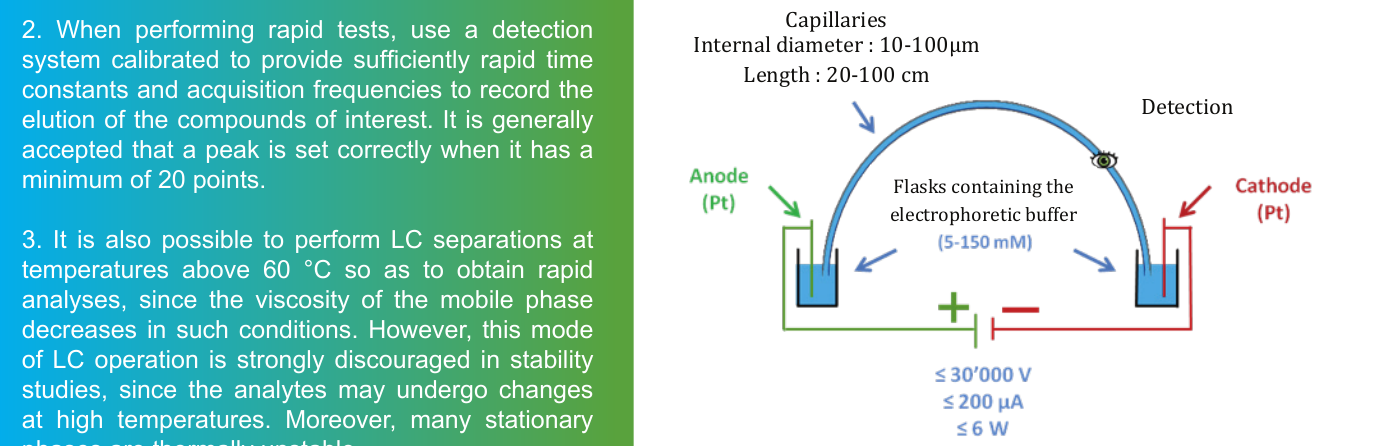
Capillaries Internal diameter : 10-­‐100µm Length : 20-­‐100